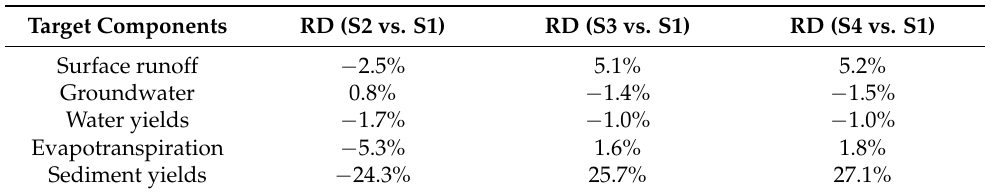
Table 3. Relative difference (RD) values of the target components with the updated land- use input conditions vs. static input condition.